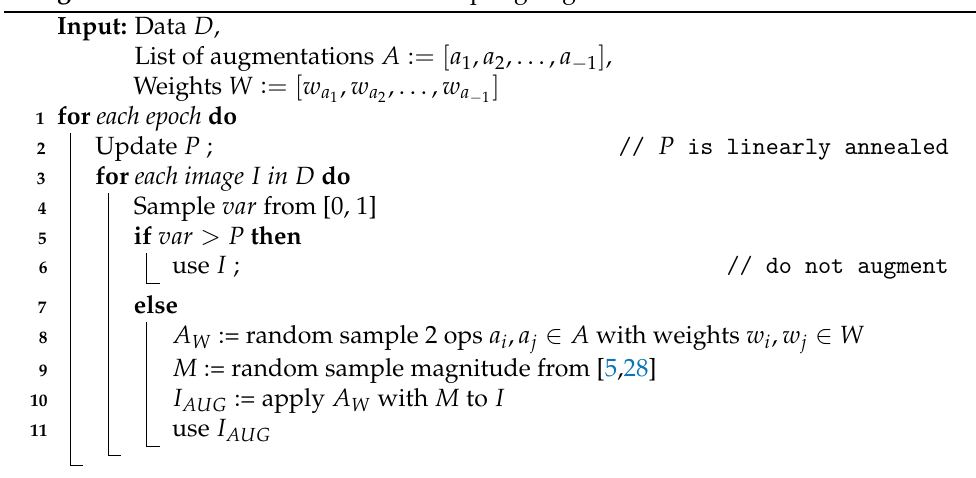
Algorithm 2: Pseudocode for